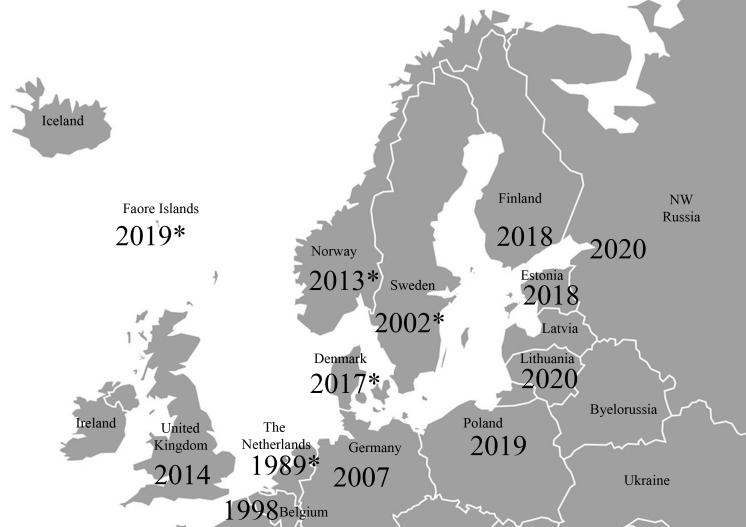
The years of first findings of Ctenolepisma
longicaudatum from northern European countries and regions. The source references are: Belgium (Lock 2007), United Kingdom (Goddard et al. 2016), The Netherlands (Nierop and Hakbijl 2002, Schoelitsz and Brooks 2014), Germany (Meineke and Menge 2014), Denmark (Thomsen et al. 2019), Poland (Aak et al. 2019), Faroe Islands (Thomsen et al. 2019), Norway (Aak et al. 2019), Sweden (Pape and Wahlstedt 2002, Shah and Coulson 2020), Finland (Ueda 2020), NW Russia (Ueda 2020), Estonia (original data), Lithuania (Ueda 2020). The asterisk indicates a suspicion of an earlier observation (Schoelitsz and Brooks 2014, Thomsen et al. 2019, Anders Aak, pers. comm.).